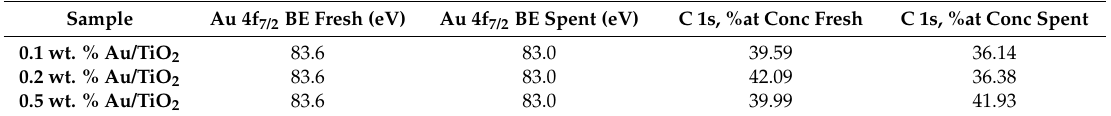
Table 4. XPS binding energy of Au 4f 7/2 region data and C atomic percentage for gold based catalysts before and after the photoactivity tests.